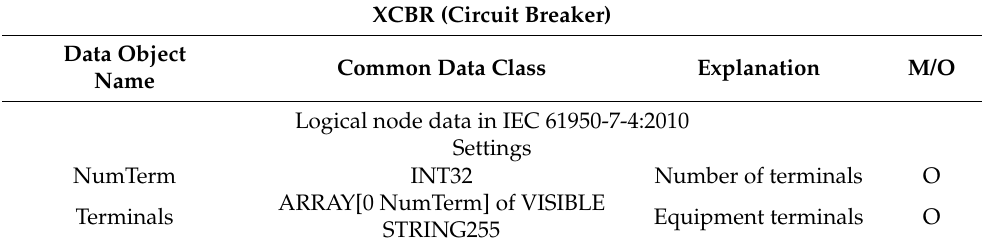
Table 1. Logical node XCBR.